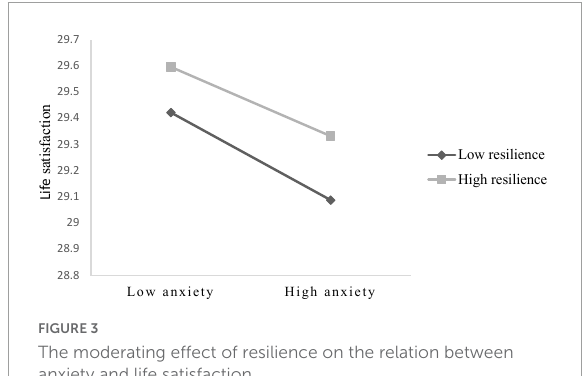
FIGURE3 The moderating effect of resilience on the relation between anxiety and life satisfaction.